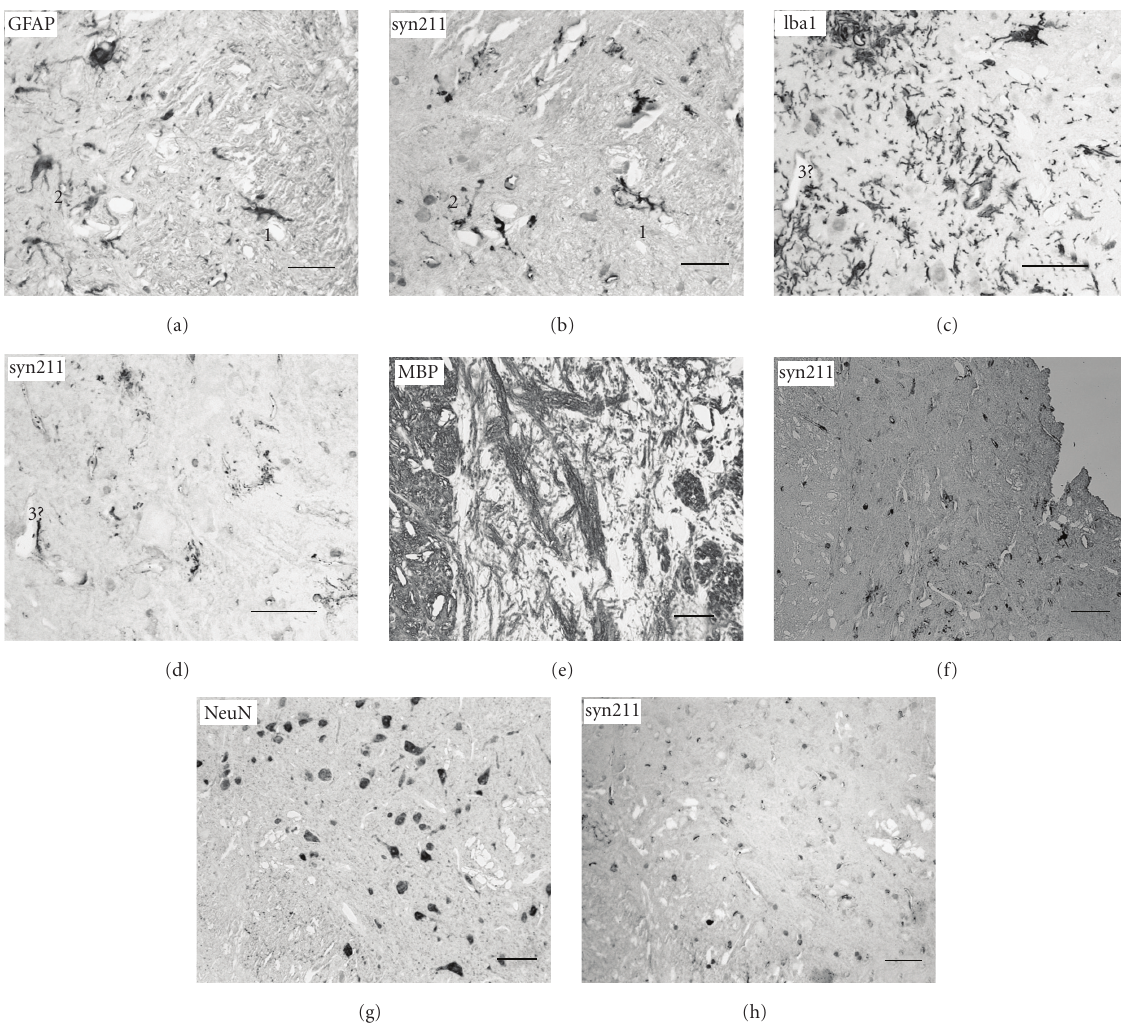
Figure 1: Light microscopic phenotyping of cells expressing the transgene in BAsyn/PaKO mouse brains. Photomicrographs of serial, 3 μ m- thick sections of the spinal cord from BAsyn/PaKO mice ((a)–(h)). The syn211-immunostaining (b) colocalized with the marker GFAP (a), indicating the transgene expression in astrocytes. In the parts of the spinal cord where many Iba1-positive cells (c) are stained, it seems that only one cell could be also positive for syn211 (d), indicating that it is not clear if the hm α -syn is expressed in microglia. For MBP- immunopositive oligodendrocytes (e) and NeuN-immunopositive (g) neurons no match with syn211-immunostaining could be detected ((f), (h)). Scale bars: (a)–(d): 30 μ m; (e)–(h) 50 μ